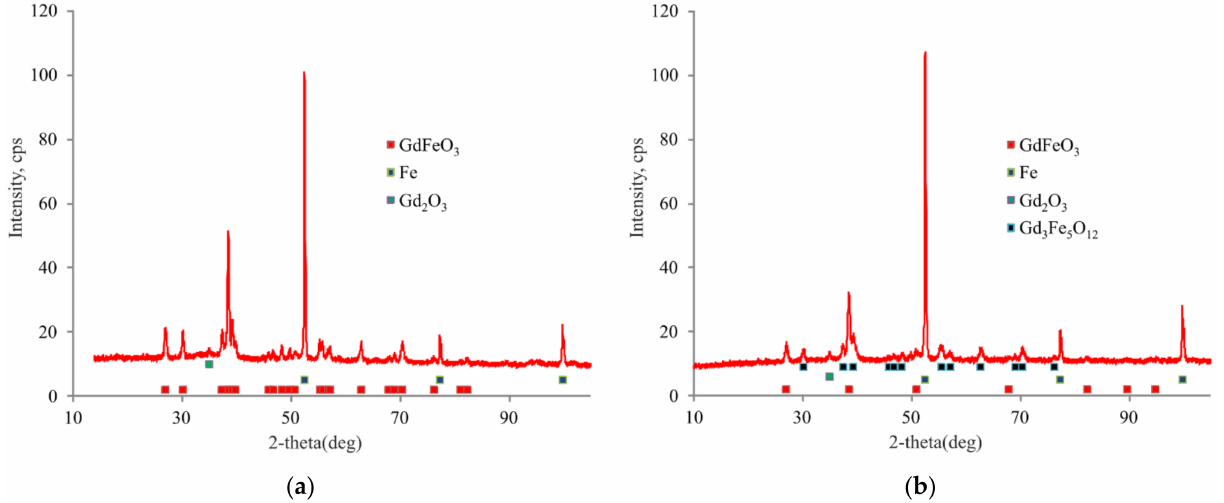
Figure 5. X-ray diffraction pattern of ( a ) an instance calculated for gadolinium ferrate and ( b ) tri- gadolinium pentairon(III) oxide.